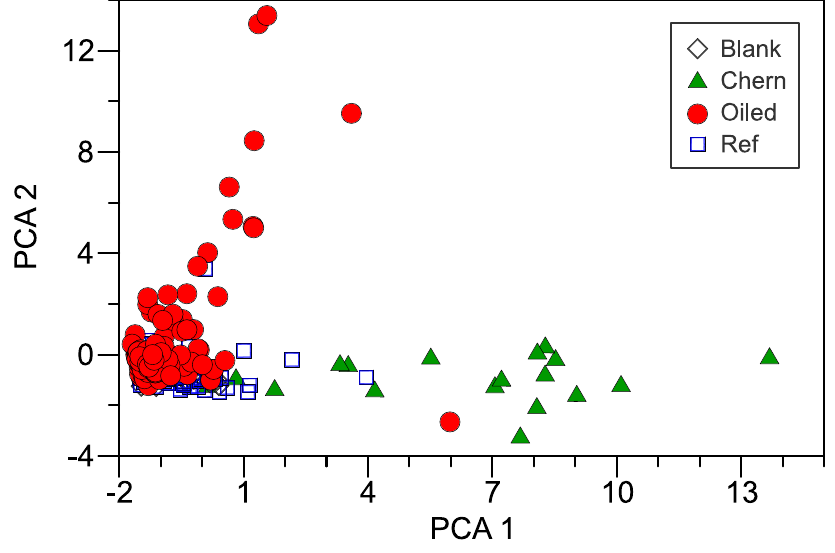
Fig 7. First and second principal components (PCA 1 and PCA 2) from the correlation matrix of normalized PAHs in passive samplers